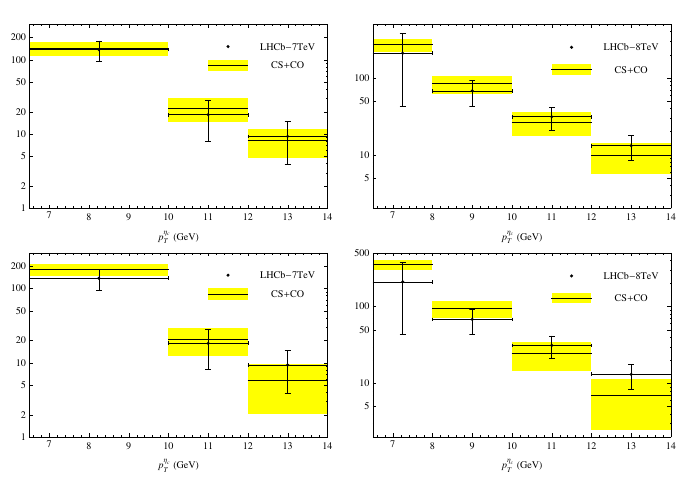
Figure 3. Comparison between NRQCD predictions calculated in the second approach as described in the text and LHCb measurements [12] of d σ/ dp T for prompt η c production at √ s = 7TeV (left panel) and 8TeV (right panel). The results shown in the lower(upper) panel are calculated with(out) the